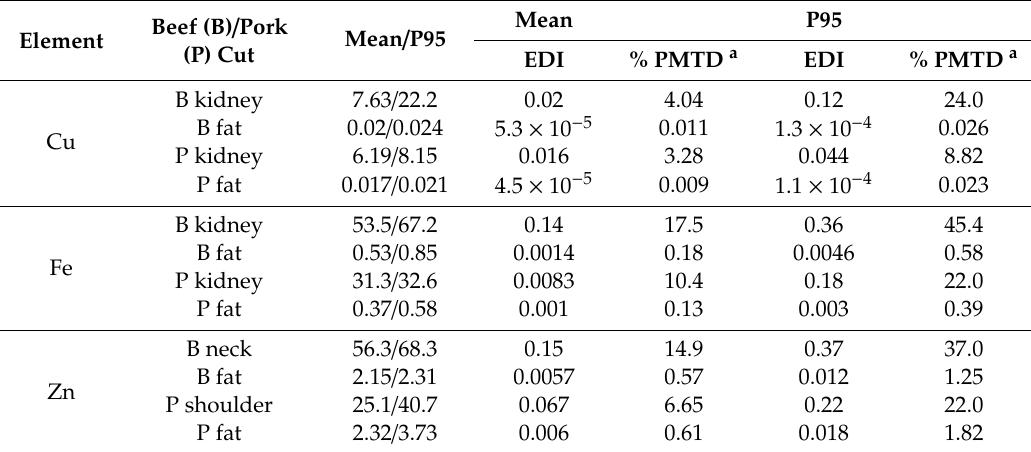
Table 6. Risk assessment and potential health exposure in relation to the toxicological limits of Cu, Fe, and Zn by the consumption of beef and pork